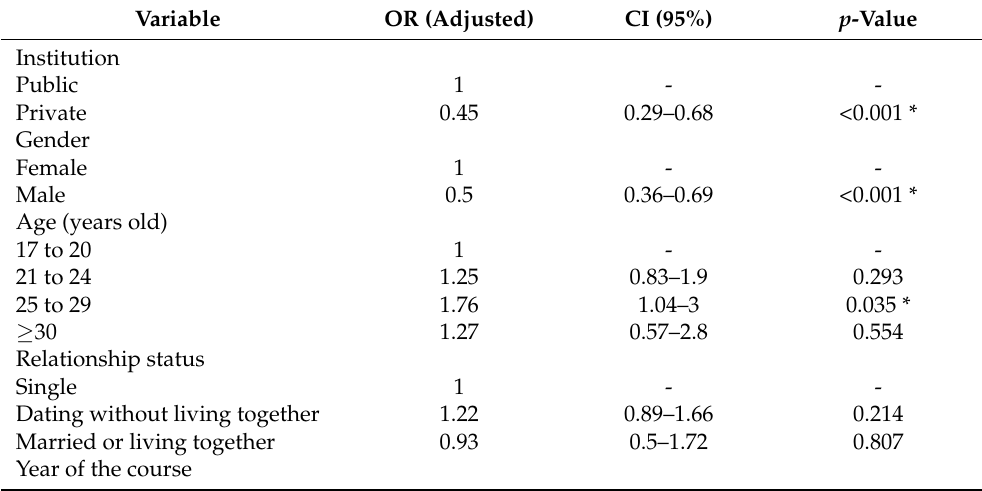
Table 5. Multivariate analysis of having already suffered mistreatment in function of the factors under